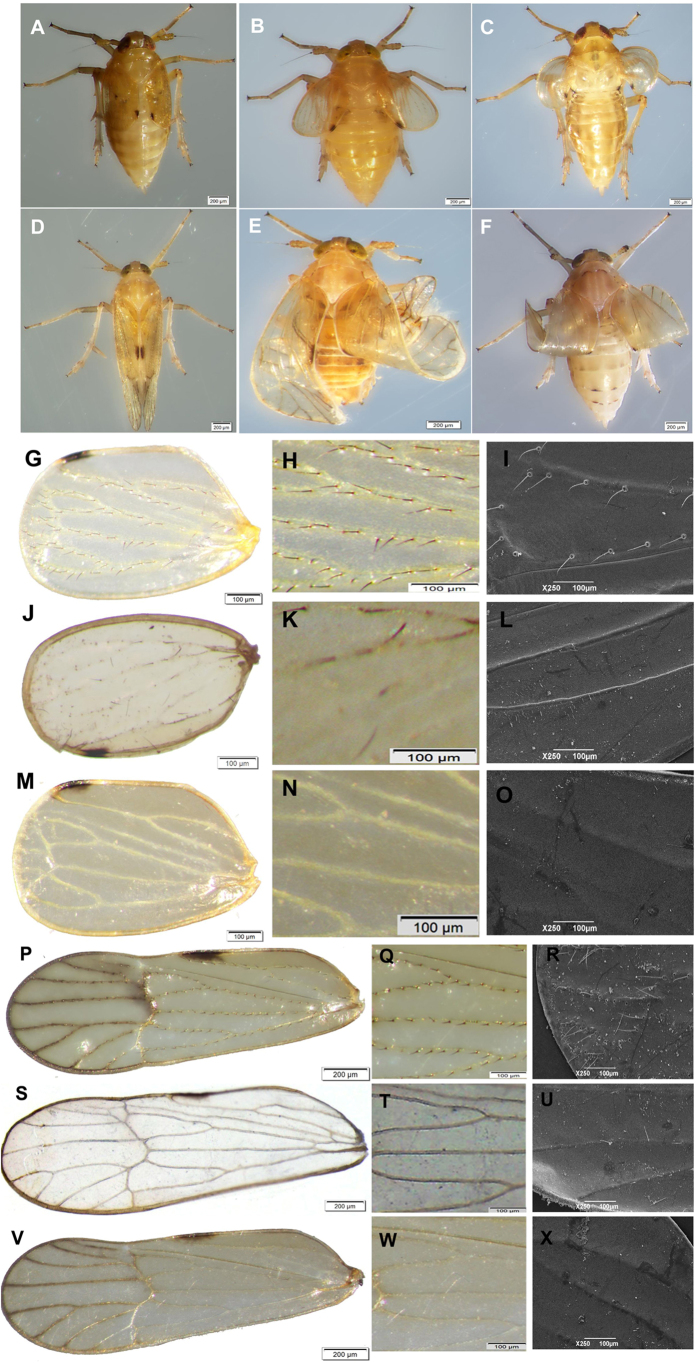
The wing phenotypes of BPHs adults emerged from nymphs injected with dsNlapAor dsNlASH (400ng per nymph) at 3rd-instar.(A) (D) short-winged and long-winged adults developed from nymphs treated with dsGFP; (B) (E) short-winged and long-winged adults developed from nymphs treated with dsNlapA; (C) (F) short-winged and long-winged adults developed from nymphs treated with dsNlASH; (G) (H) (I) forewing of short-winged adults developed from nymphs treated with dsGFP (magnified 60 times, 100 times and 250 times respectively); (J) (K) (L) forewing of short-winged adults developed from nymphs treated with dsNlapA (magnified 60 times, 100 times and 250 times respectively); (M) (N) (O) forewing of short-winged adults developed from nymphs treated with dsNlASH (magnified 60 times, 100 times and 250 times respectively); (P) (Q) (R) forewing of long-winged adults developed from nymphs treated with dsGFP (magnified 60 times, 100 times and 250 times respectively); (S) (T) (U) forewing of long-winged adults developed from nymphs treated with dsNlapA (magnified 60 times, 100 times and 250 times respectively); (V) (W) (X) forewing of long-winged adults developed from nymphs treated with dsNlASH (magnified 60 times, 100 times and 250 times respectively).